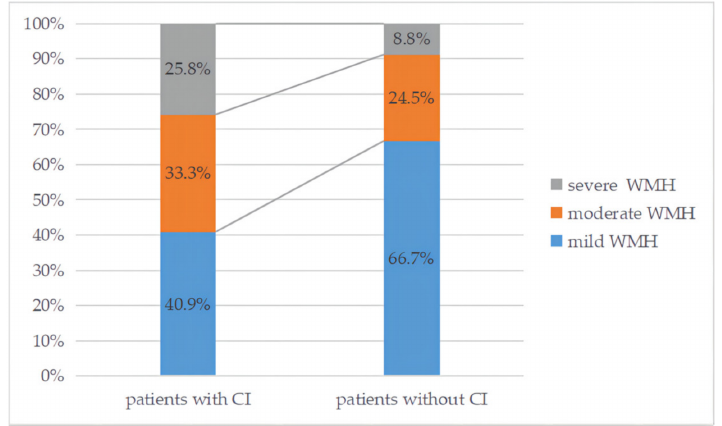
Figure 2. Distribution of WMH severity in patients with and without cognitive impairment. CI, cognitive impairment; mild WMH (Fazekas score = 0–2); moderate WMH (Fazekas score = 3–4); severe WMH (Fazekas score = 5–6).